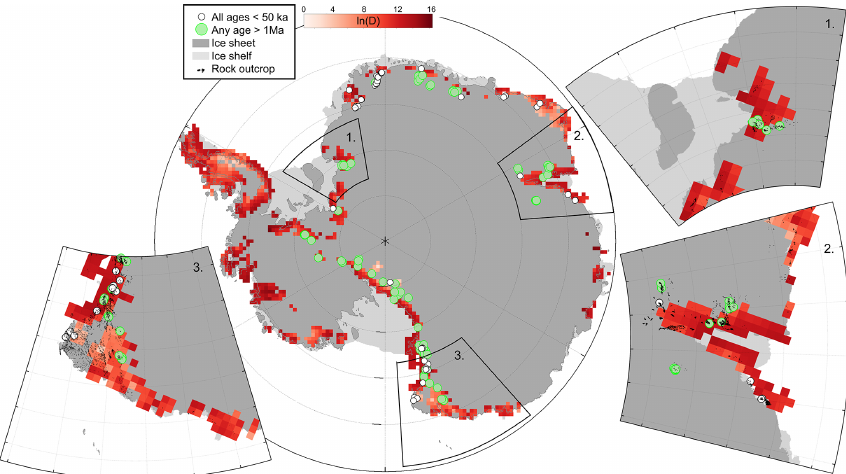
Figure 14. CDF difference metric D at possible locations for model–data comparison; D is cropped to locations within 50km of rock outcrops and where total modelled ice thickness changes are greater than 400m (following Criterion 3). Existing exposure-age samples are plotted according to age so as to highlight sites where long-exposed bedrock surfaces are (green dots) and are not (white dots) likely to exist. In general, ice-free areas where apparent exposure ages > 1Ma have been observed (green dots) are located in relatively high-elevation inland regions (e.g. Criterion 4). Sites where bedrock exposure-age data have been collected, but only relatively young exposure ages have been observed, are in low-elevation coastal regions where subglacial and subaerial erosion are more likely to occur. Modern ice sheet and ice shelf extent from Fretwell et al. (2013). Inset panels 1, 2, and 3 show Shackleton Range, Lambert Glacier region, and Wilkes Basin margin/Northern Victoria Land, respectively, with rock outcrop locations in